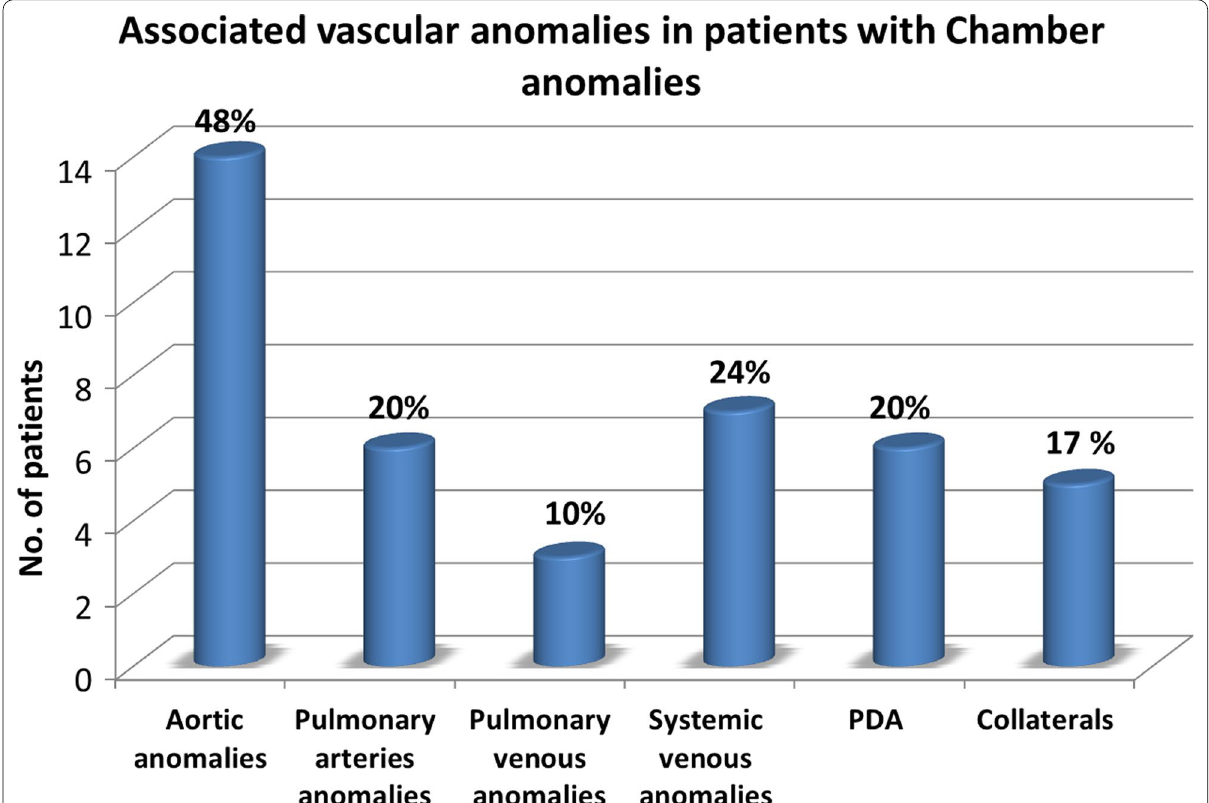
Fig. 1 Bar graph showing associated vascular anomalies in patients with chamber anomalies